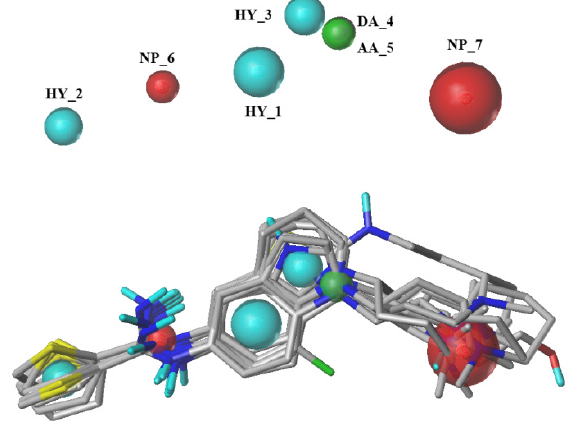
Figure 2. Selected pharmacophore MODEL_012 and the molecular alignment of the compounds used to elaborate the